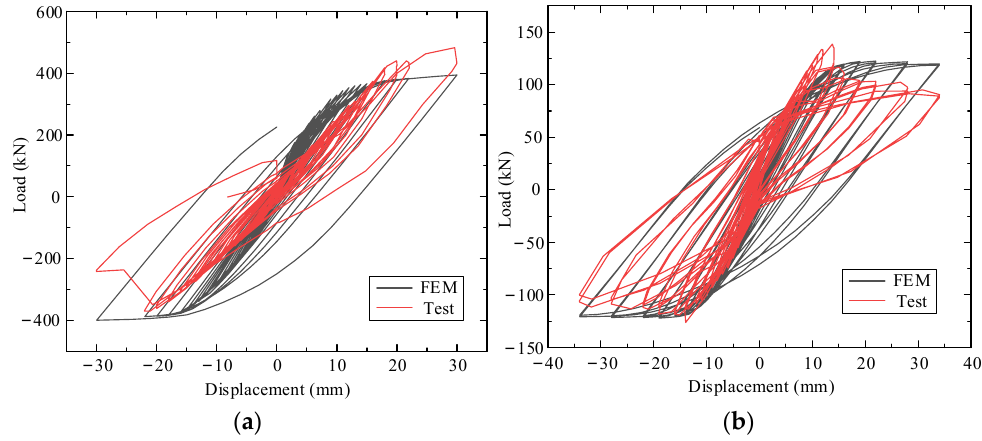
Figure 16. Comparison of the measured and calculated load displacement curves. ( a ) Shaped specimen; ( b ) shaped specimen. Table 3. Comparison of the measured and calculated lateral bearing capacities of specimens.